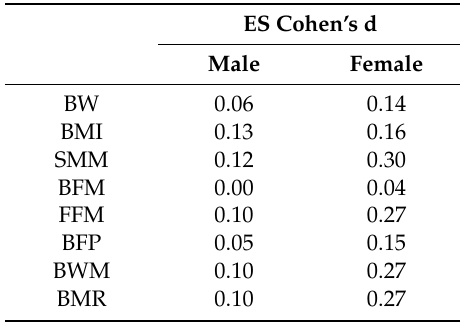
Table 7. Cohen’s (d) ES of BC parameters between T1 and